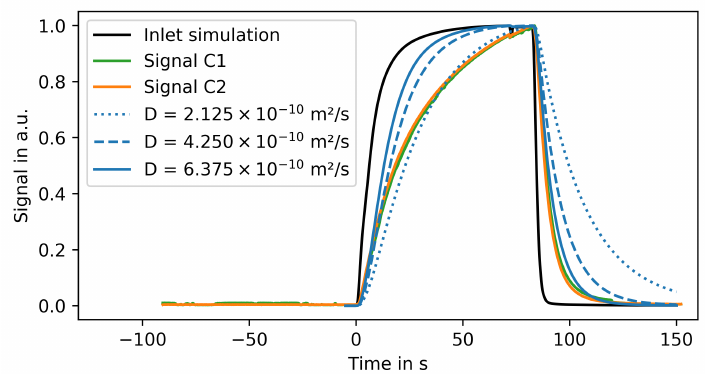
Figure 9. Spatial average of measured fluorescence signals in different regions of the microfluidic chip and simulated concentration profiles for the same chamber geometry using different diffusion